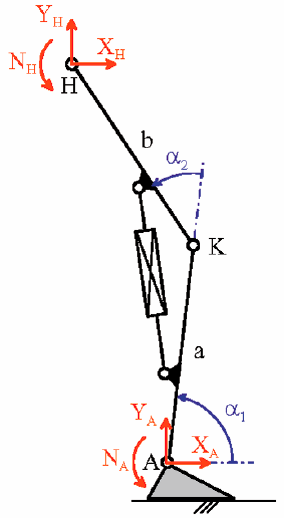
Figure 9 . Planar model of the lower limb with a prosthesis (a = b = 0.5 m). Figure 9. Planar model of the lower limb with a prosthesis (a = b = 0.5 m). The chosen datasets refer to walking speeds that are common in daily-life activities. The chosen datasets refer to walking speeds that are common in daily-life